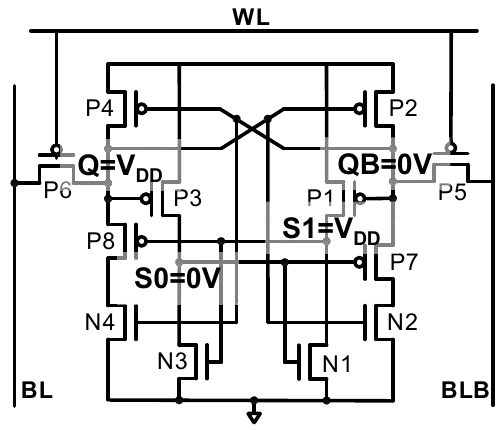
Figure 6. Schematic of RHBD-12 T SRAM cell. Unlike Q or QB , the S0 or S1 node can suffer from both 0 to 1 and 1 to 0 node upsets. However, these upsets can be recovered as follows. First, if 1 to 0 upset occurs at the node S1 for the data “1” state, P8 is turned on, while N3 is turned off. Although P8 is turned on, Q is not pulled down because N4 is still off. Thus, QB is kept low and P1 stays turned on, and S1 is recovered to V DD . Second, if 0 to 1 upset occurs at the node S0 for the data “1” state, N1 is temporarily turned on to pull down the node S1, which turns on P8. Again, however, N4 remains off, the high Q is unchanged, and QB can remain low. Thus, the node S1 is pulled back up to V DD , leading to the pulling down of S0 back to its original value 0 V. The shortcoming of RHBD-12 T is the large read access time due to the use of the pFET access transistor and pull-down transistor. For reading data “1”, the pre-charged BLB is discharged by the cell current flowing through P5-P7-N2. However, unlike other memory cell structures, the magnitude of V GS in access transistor P5 and pull-down transistor P7 is decreased as BLB is discharged, which severely slows down the read operation. In addition, the use of pFET transistors significantly degrades the write speed and